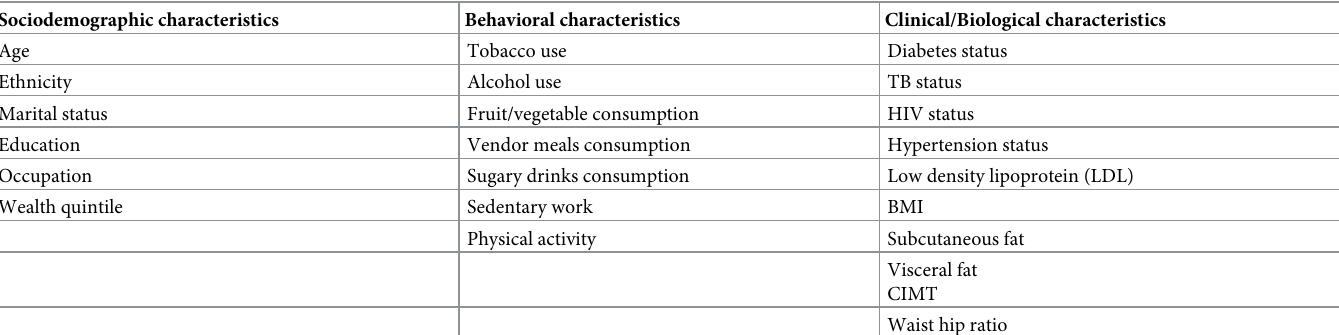
Table 1. Summary of characteristics included.